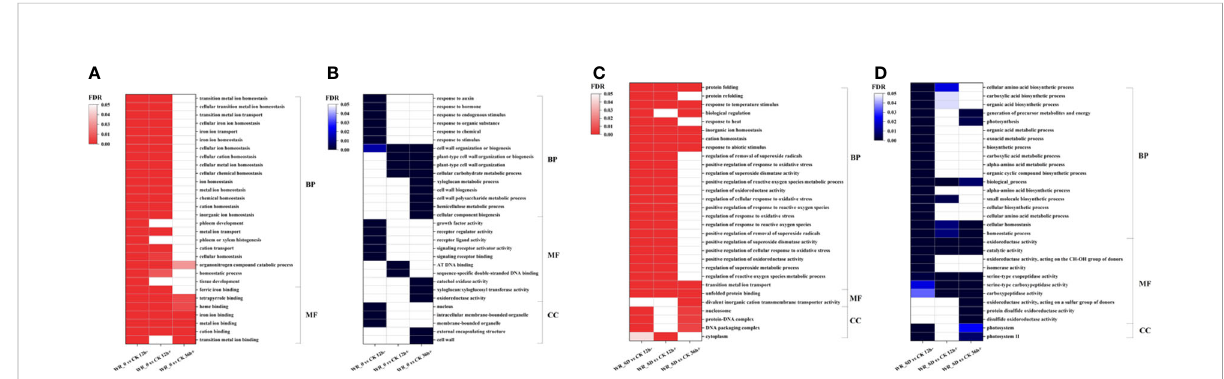
FIGURE 6 GO terms enriched in DEGs of pairwise comparisons within the entire WR_ q cri vs. CK set and WR_SD vs. CK set. (A) , GO terms enriched in upregulated DEGs within the WR_ q cri vs. CK set. (B) , GO terms enriched in downregulated DEGs within the WR_ q cri vs. CK set. (C) , GO terms enriched in upregulated DEGs within the WR_SD vs. CK set. (D) , GO terms enriched in downregulated DEGs within the WR_SD vs. CK set. The top 30 signi fi cant ( P <0.01) GO terms are shown in the graph, and the FDR value of each item was used to draw a